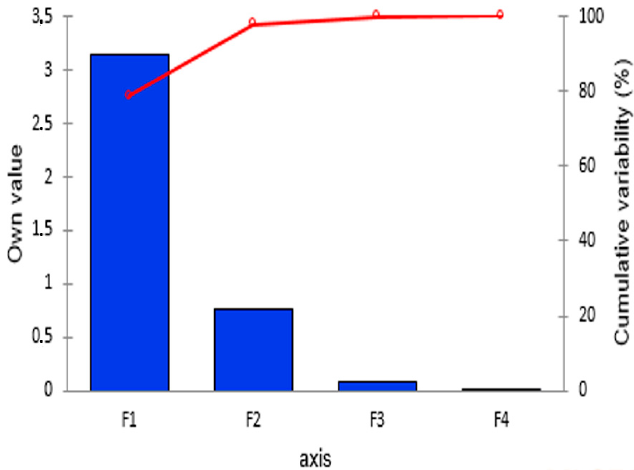
Figure 1. Representation of the eigenvalues and the cumulative variability.